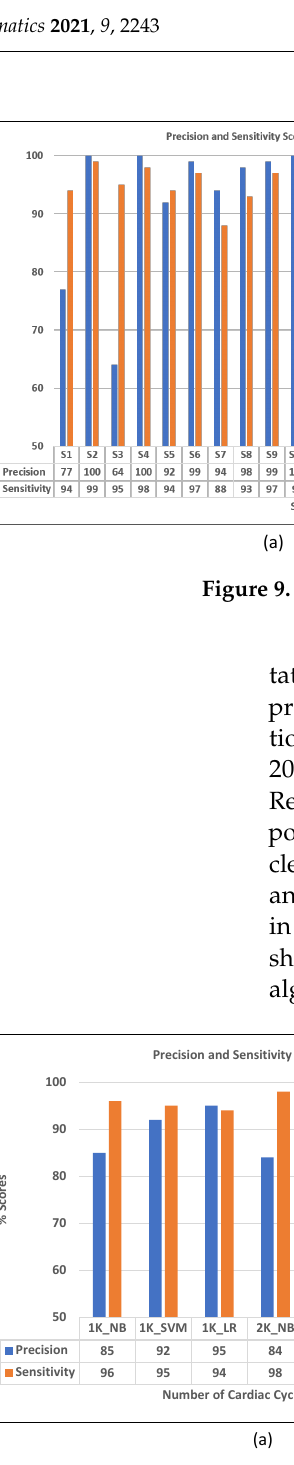
Figure 10. Precision and sensitivity values of ( a ) Experiment 5, ( b ) Experiment 6. Recently, a framework for delineation of SCG signals was proposed in [70]. The method was analyzed on eight male patients in two different breathing patterns: i.e., normal and stopped breathing. The performance of the proposed delineation framework was analyzed corresponding to IM, AO, IC, AC, and MO points. The results are shown in Figure 11. The results show that the proposed method achieves the average precision and sensitivity score of 97.8% and 97.16%, respectively, on the normal breathing database, while 95.33% and 93.5%, respectively, on the stopped breathing database. This higher sensitivity and precision score indicates better performance for the detection of AO